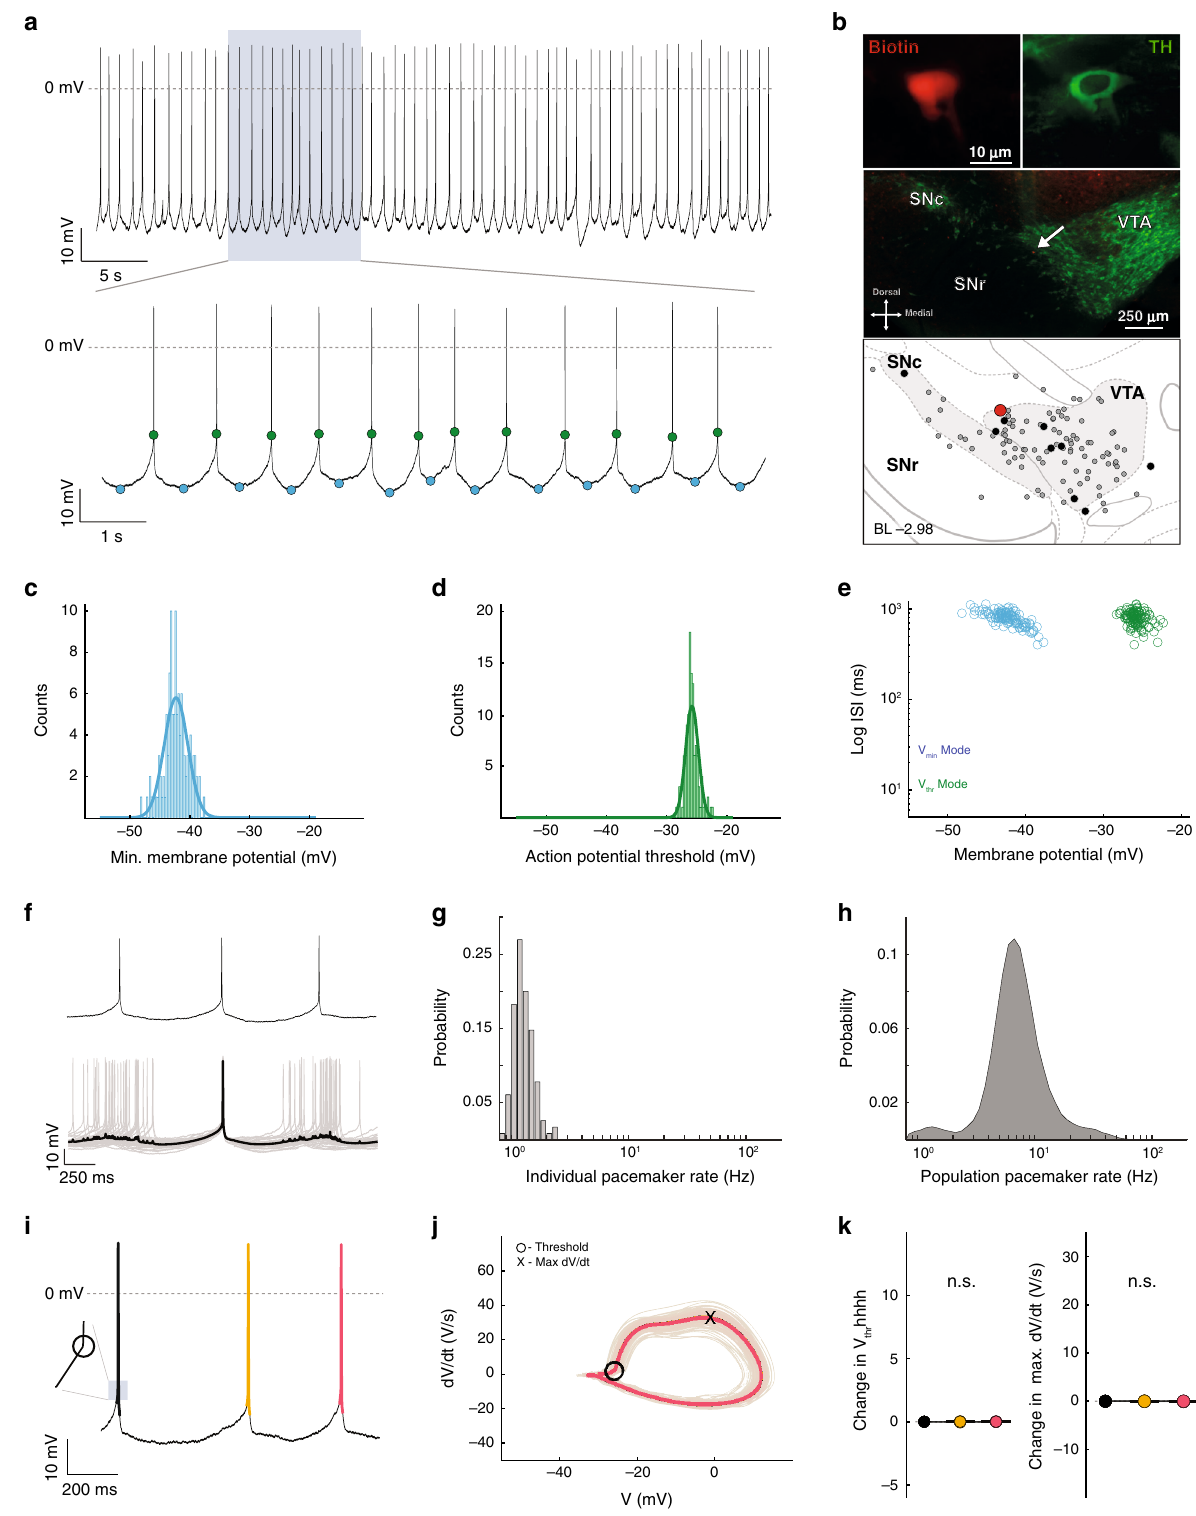
mean = − 37.9 ± 3.7 mV, SD = 1.5 ± 0.4; n = 10, N = 10). As in Fig. 2f, the V thr distribution was also unimodal (Fig. 4d; BC = 0.38 ± 0.09; V thr mean = − 28.91 ± 2.051 mV, SD = 1.73 ± 0.44 mV). When plotting the individual ISIs against the corresponding V min , the more hyperpolarized membrane potentials (Fig. 4c, Mode 1) were almost exclusively associated with longer ISIs in the range of 600 – 1200 ms, forming an independent cluster in the plot